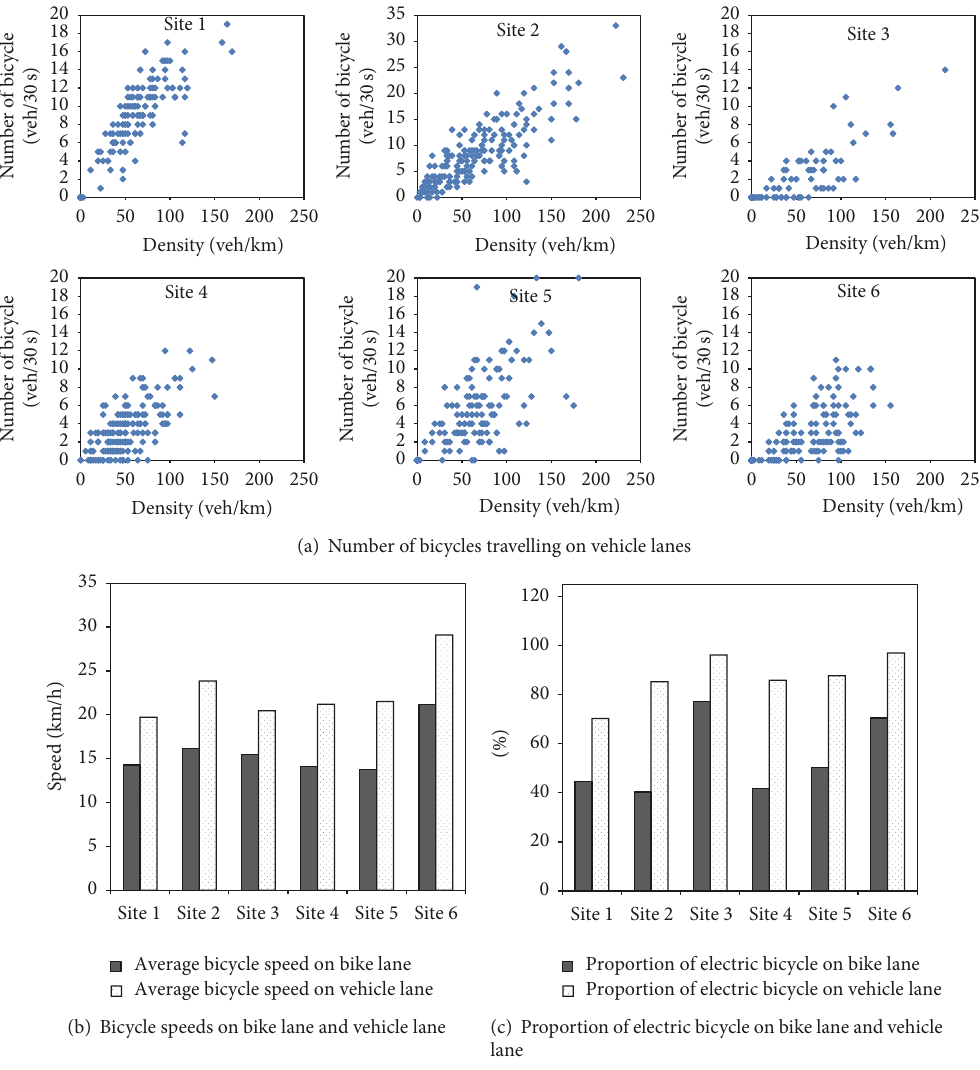
Figure 5: Traffic flow features on bike lanes and vehicle